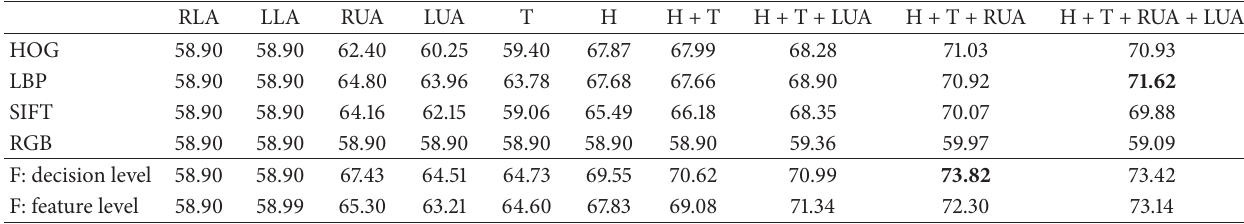
Table 2: Gender recognition accuracies (%) with annotated body parts on